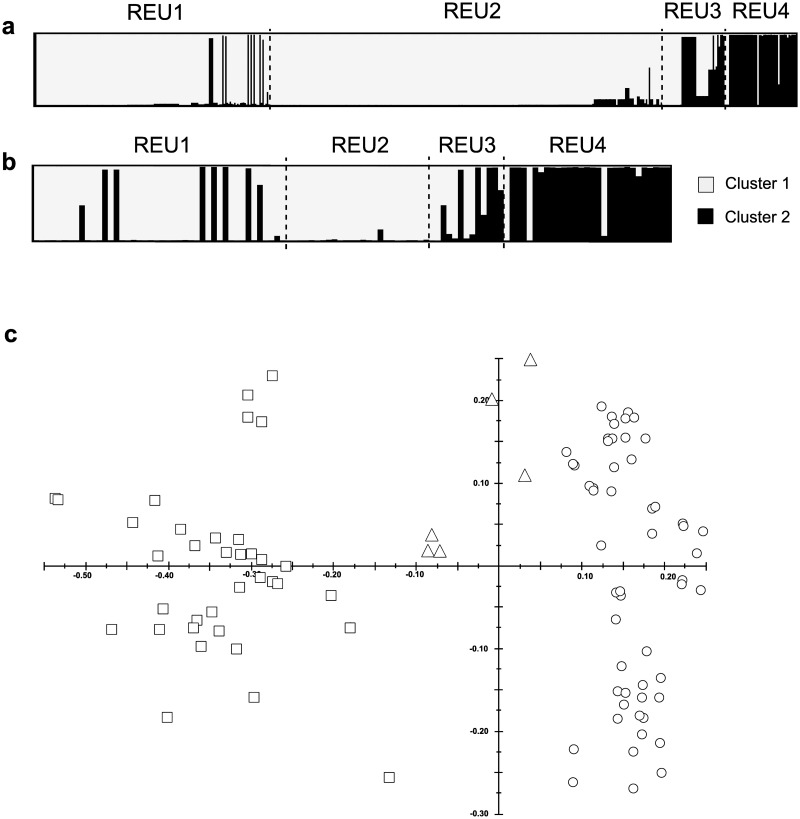
Results of the clustering analysis for K = 2, (a) for the entire dataset (N = 510) and (b) for the truncated dataset containing one representative per multi-locus genotype and per site (N = 109). For each plot, populations are separated with dash lines. (c) Principal Component Analysis estimated on the truncated dataset (based on 13 microsatellites). Axes 1 (horizontal) and 2 (vertical) represent 31.56% and 10.88% of the total variance, respectively. Symbols are the same than in Fig 3.